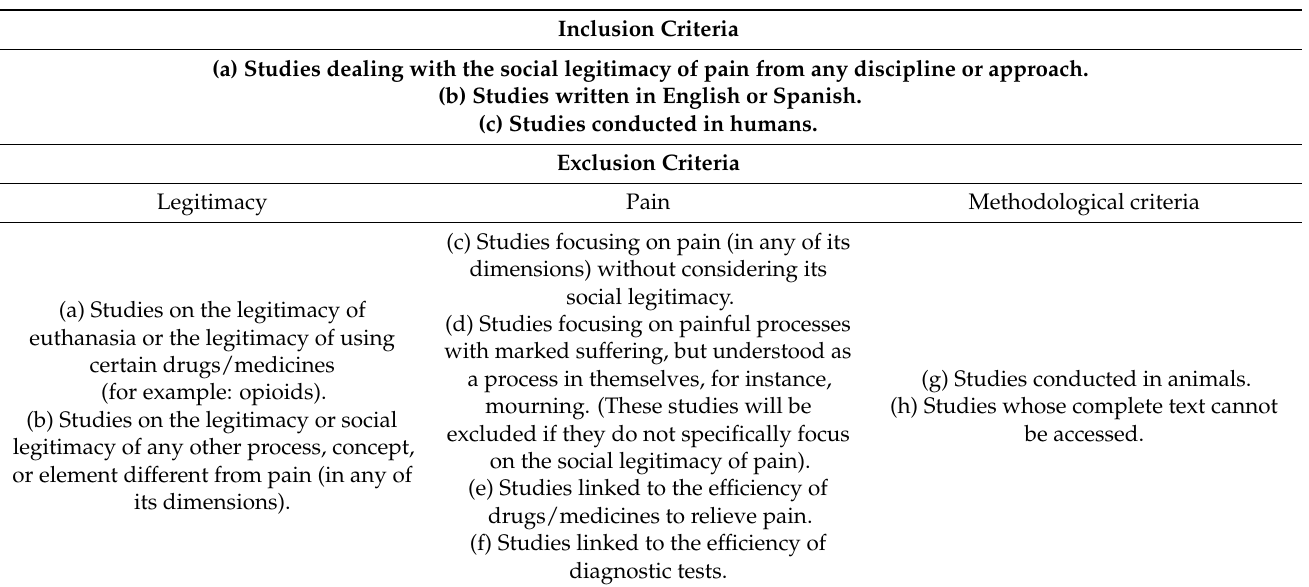
Table 2. Inclusion and exclusion criteria